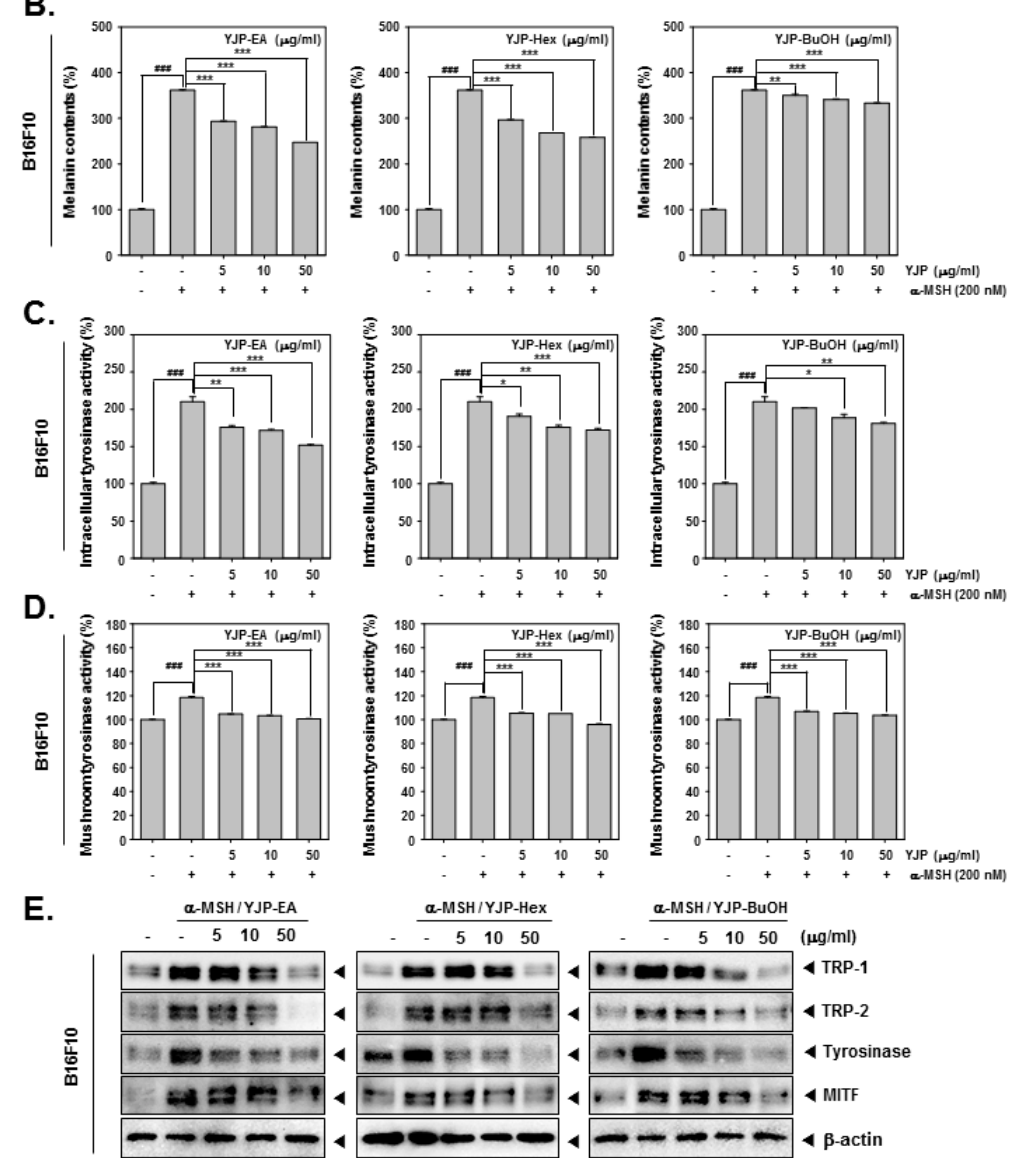
Figure 4. Melanin inhibition effects of YJP-EA, Hex, and BuOH on B16F10 cells. ( A ) B16F10 cells were treated with YJP-EA, Hex, and BuOH for 24 h. Next, the cell viability was measured using the MTT assay. ( B ) Melanin contents from α -MSH-stimulated B16F10 cell. The cells were treated with α -MSH (200 nM) and YJP-EA, Hex, and BuOH for 48 h. The cell lysates were measured at 490 nm. ( C ) To measure intracellular tyrosinase activity, the B16F10 cells were treated with -MSH (200 nM) and YJP-EA, Hex, and BuOH for 72 h. L-DOPA was added into the lysates and measured at 490 nm. ( D ) The mushroom tyrosinase activity was evaluated at -MSH (200 nM) and in YJP-EA-, Hex-, and BuOH-treated B16F10 cells. The supernatants with L-DOPA and tyrosinase were measured at 475 nm. ( E ) The whole cell lysates were analyzed by Western blot analysis. All experiments were performed individually in triplicate. *** p < 0.001 vs. α -MSH-treated cells, ** p < 0.01 vs. α -MSH-treated cells, and * p < 0.05 vs. α -MSH-treated cells. ### p < 0.001 vs. non-treated (NT)